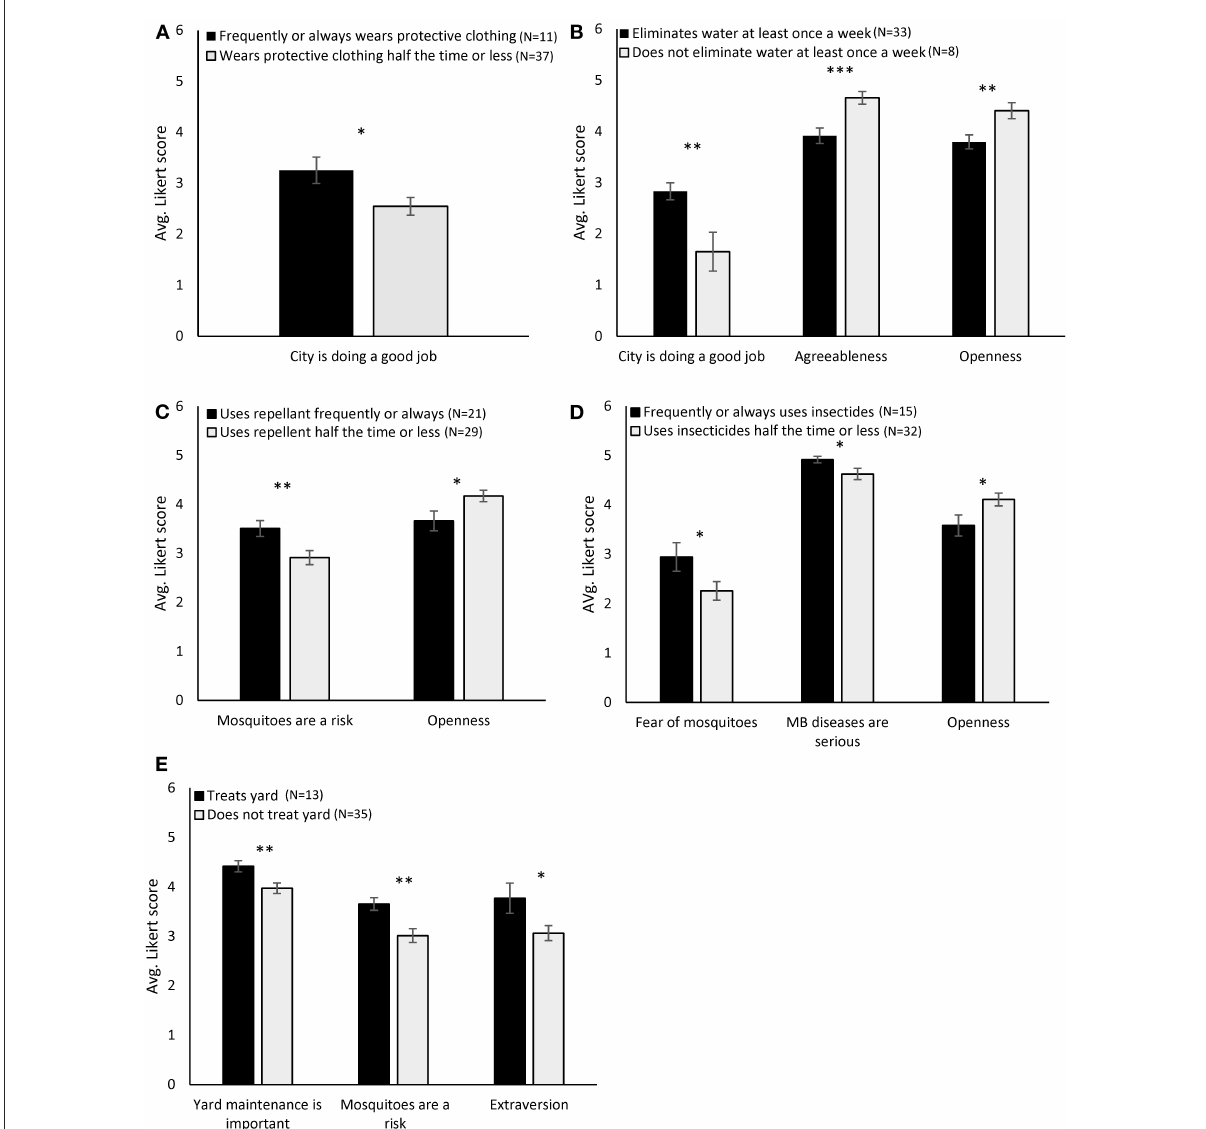
FIGURE3 Relationship of dichotomized practices with knowledge, attitudes, and personality. Significant differences were determined by individual t -tests where the two groups compared were those that reported appropriate practice of PPMs and those that did not. PPMs were (A) Wears protective clothing, (B) Eliminates water, (C) Uses repellents, (D) Uses insecticides, (E) Treats yard. * p < 0.05, ** p < 0.01, *** p <